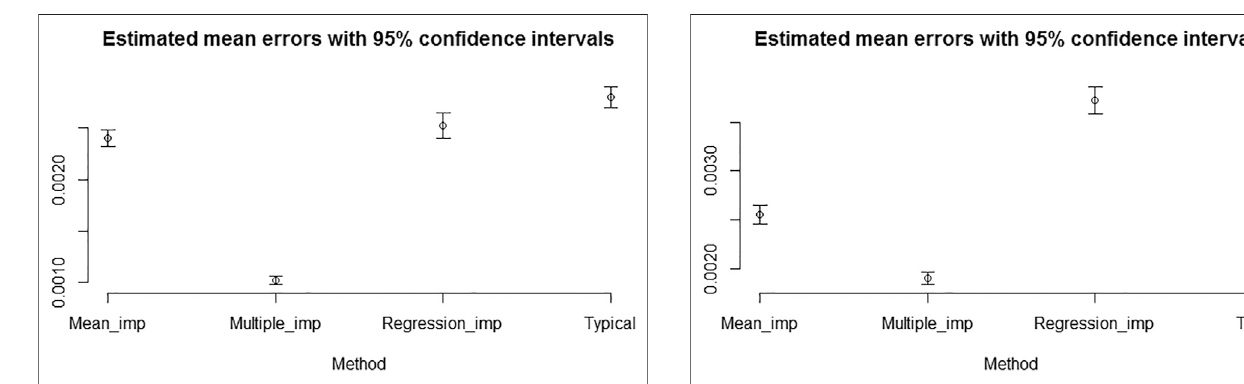
FIGURE 5 | Estimated mean errors with 95% con fi dence intervals for computing Brier scores with 25% overall missing values introduced not at random.